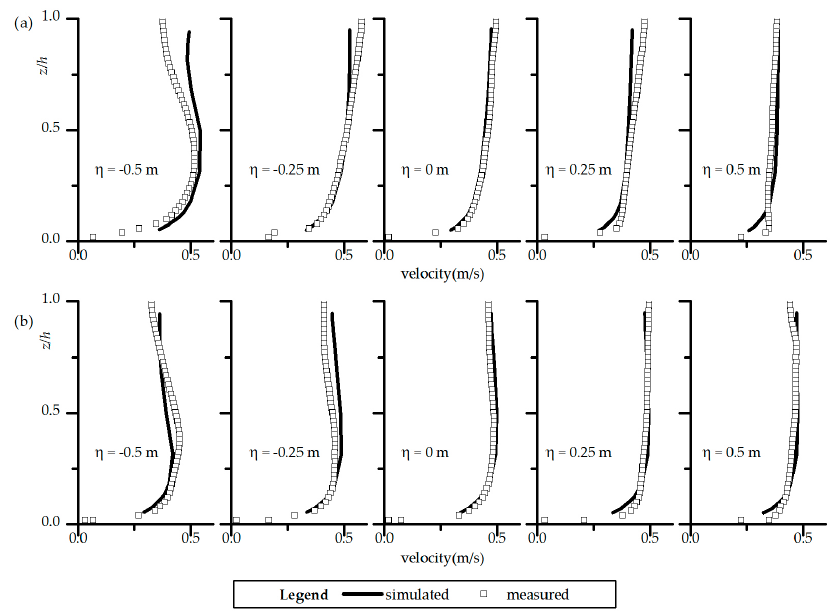
Figure 5. Calculated streamwise velocity profiles in comparison with the measurements: ( a ) Cross-section 90°; ( b ) cross-section 180° . η is the position in the lateral direction from the central line towards the outer bank.